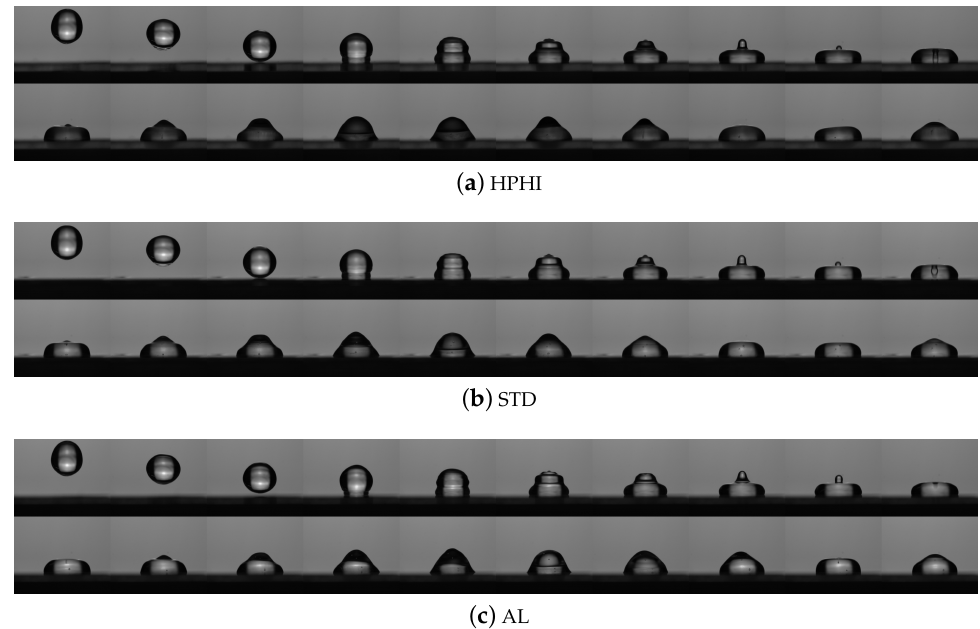
Figure 5. Frames from the high-speed video (at 909 fps) of a drop falling on each of the investi- gated